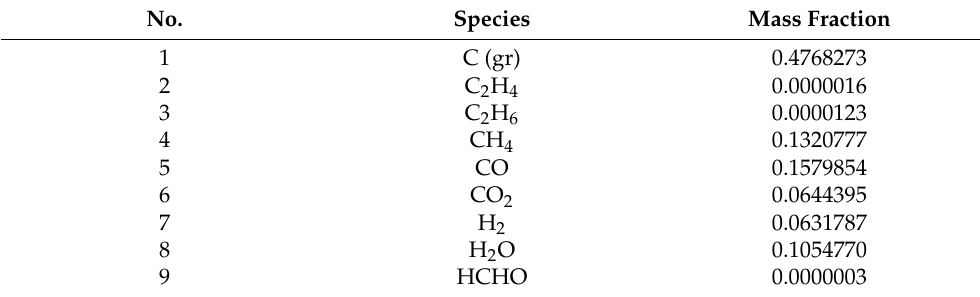
Table 7. Species mass